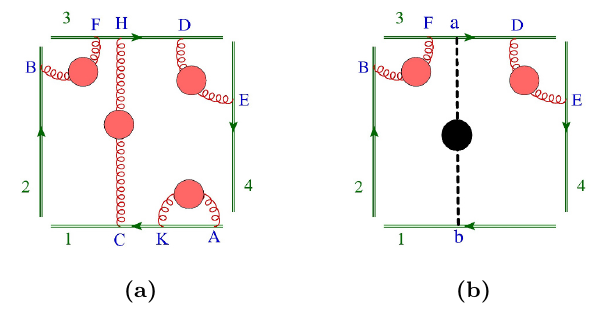
(1 , 1 , 3 , 3) and its 4